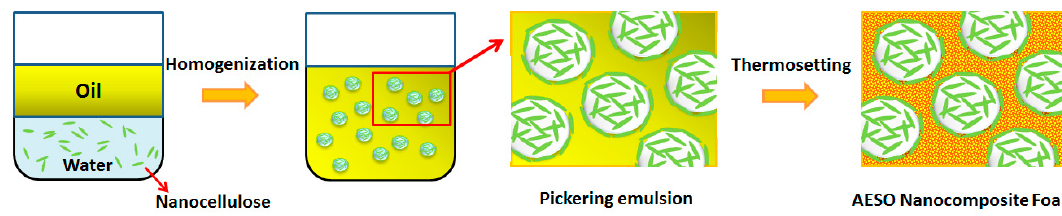
Figure 2. Schematic illustration of thermosetting acrylated epoxidized soybean oil (AESO) nanocomposite foam prepared from Pickering emulsion templating.